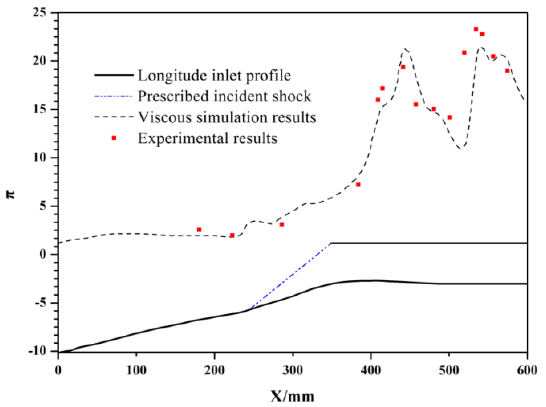
Figure A2. Experimental and numerical results: the longitudinal static pressure distribution.